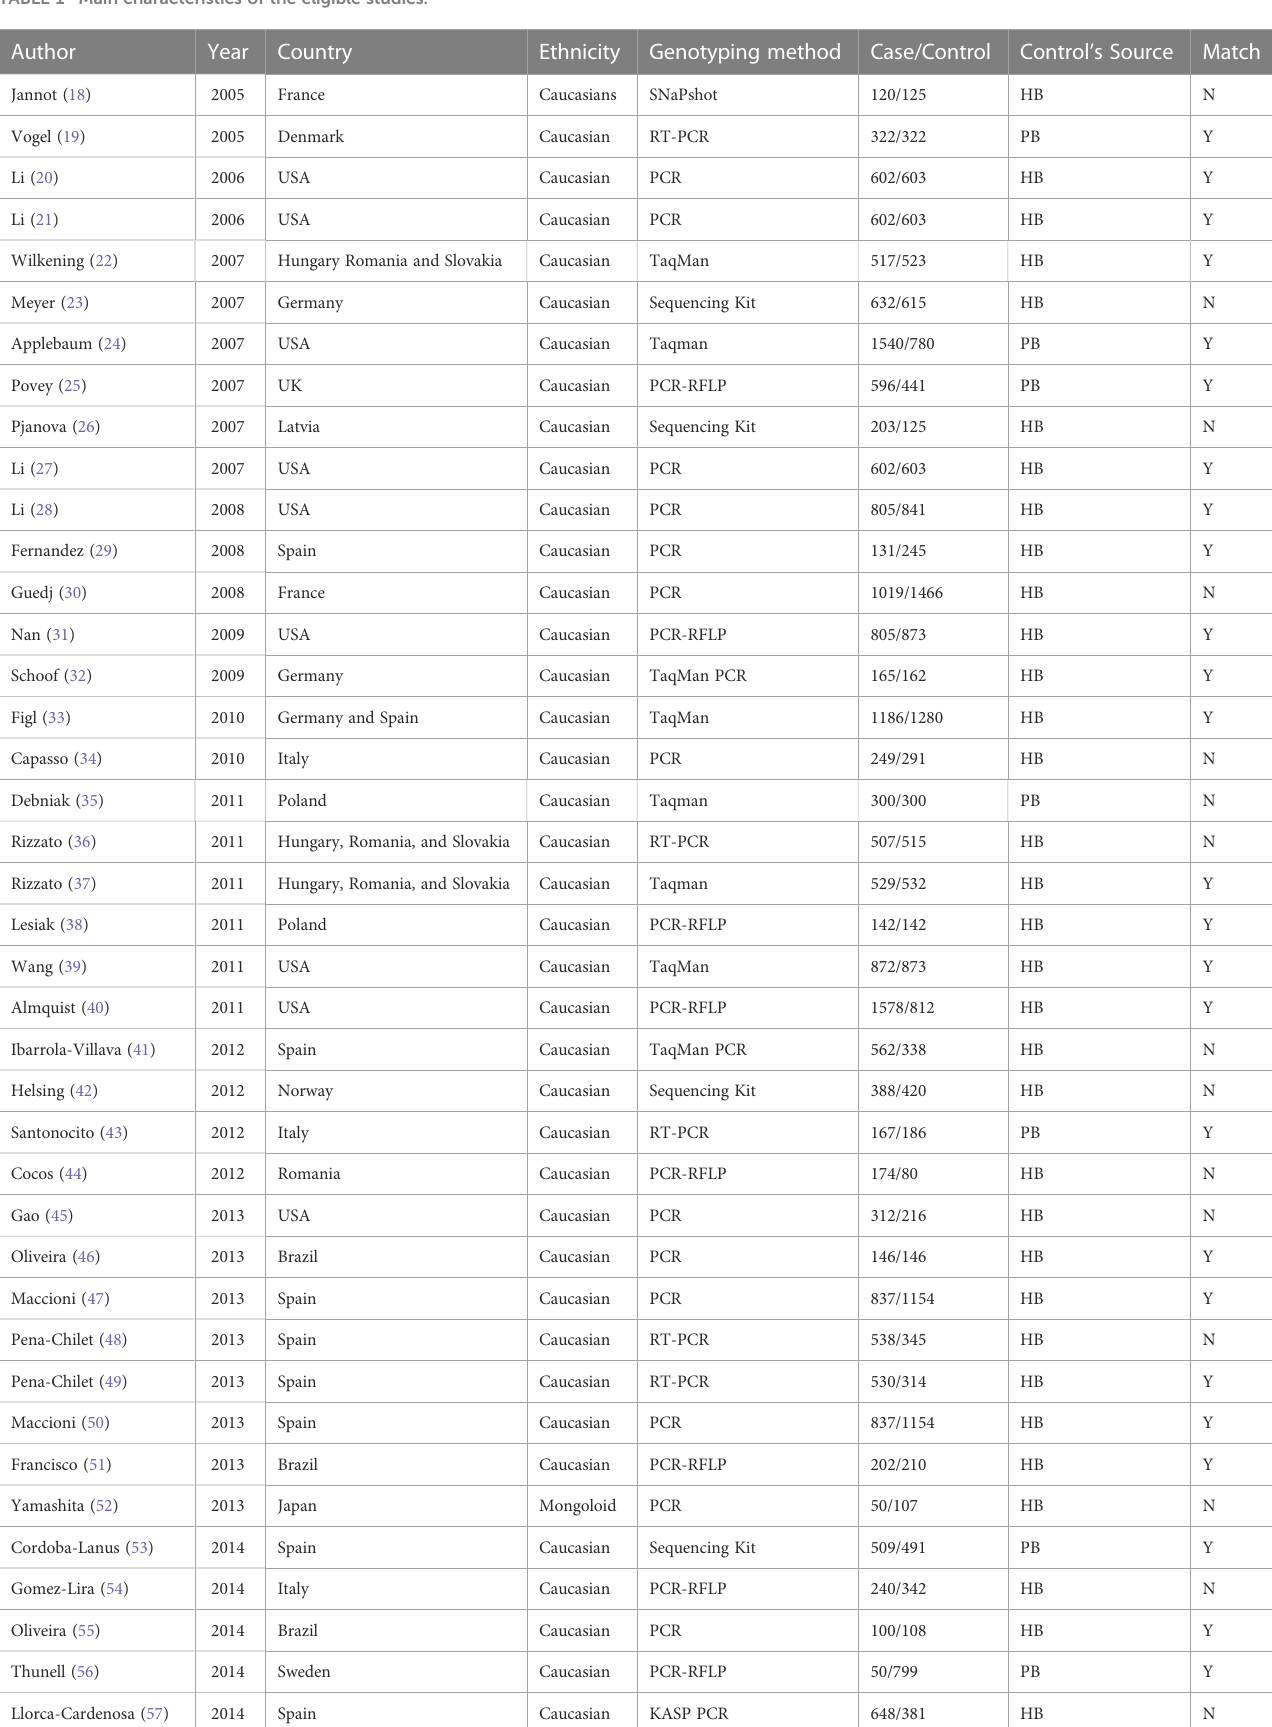
TABLE 1 Main characteristics of the eligible